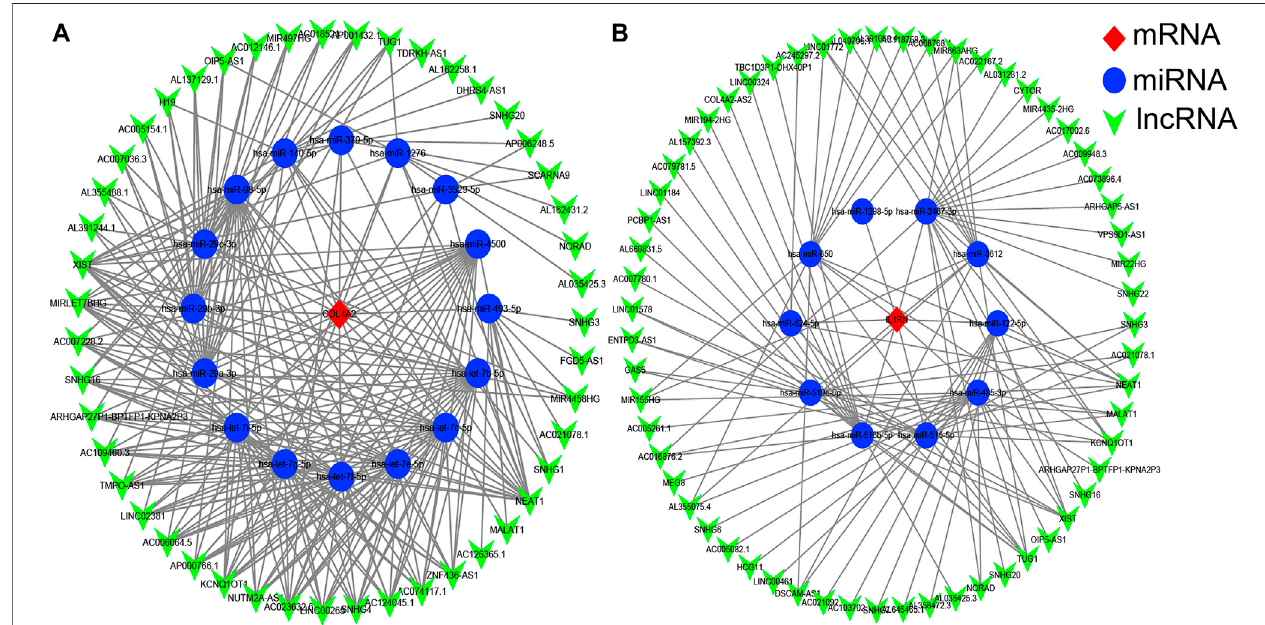
FIGURE 5 | The competitive endogenous RNA (ceRNA) networks of COL4A2 (A) and IL1RN (B) . Red diamonds represent the hub genes, blue circles represent microRNAs (miRNAs), and green V represents long noncoding RNA (lncRNA).